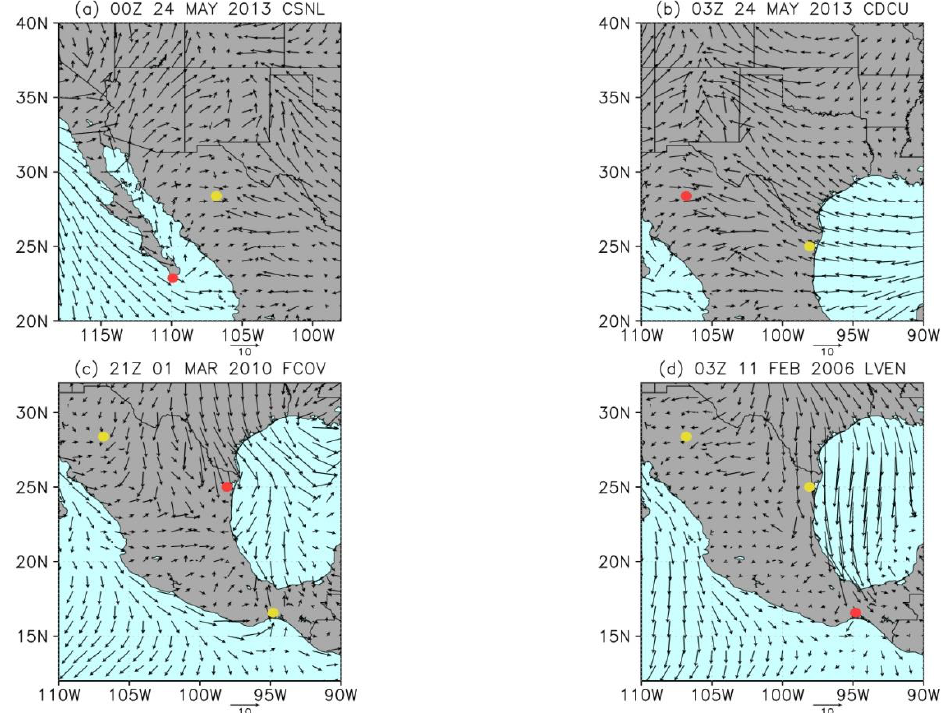
Figure 4. Cold fronts affecting ( a ) CSNL, ( b ) CDCU, ( c ) FCOV and ( d ) LVEN. From ERA5 [42] surface wind for typical cold fronts causing wind ramp. Dots show weather stations location. Red dot indicates weather station or mast experiencing the wind ramp.